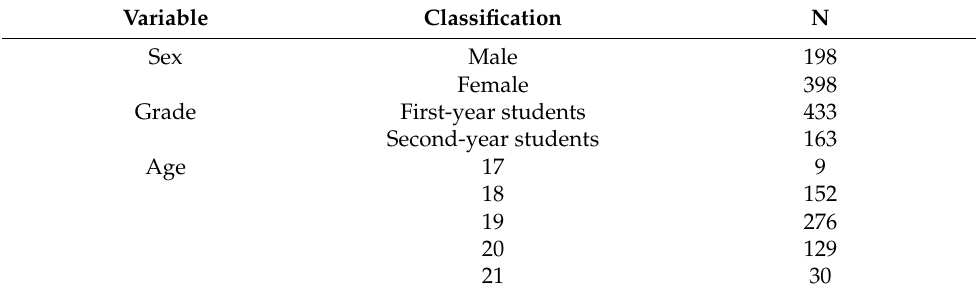
Table 7. Demographic Characteristics of the Test Samples.